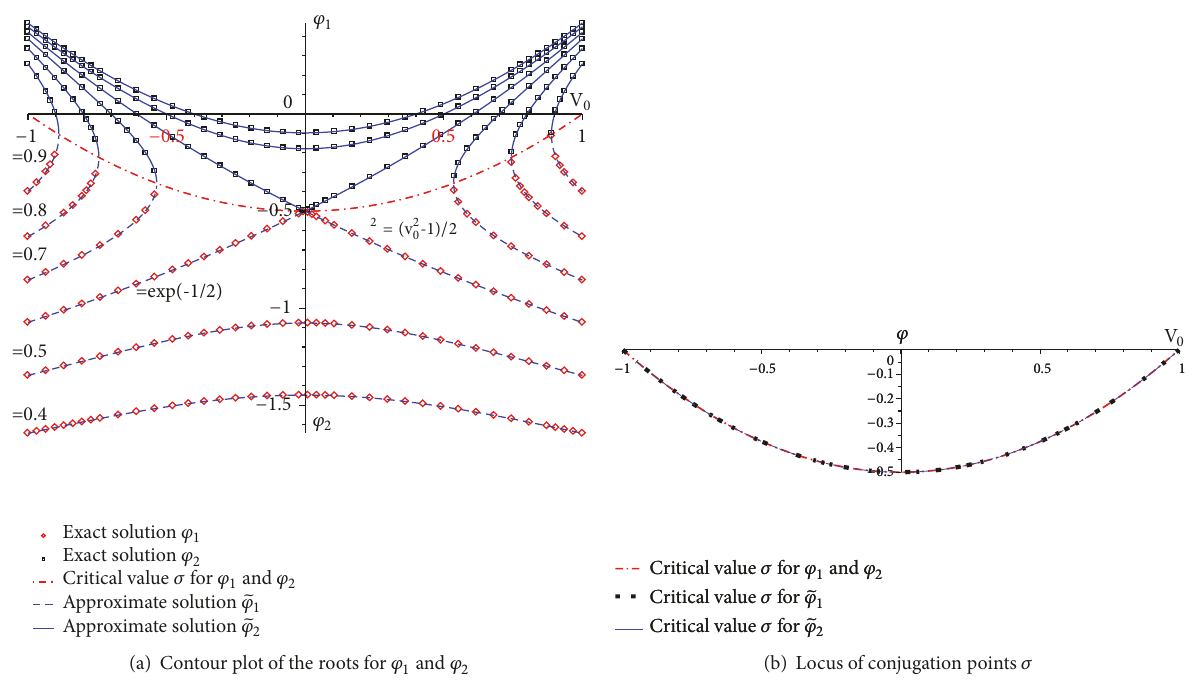
Figure 7: Contour plot of the roots 𝜑 1 and 𝜑 2 as functions of the parameter 𝜎 .